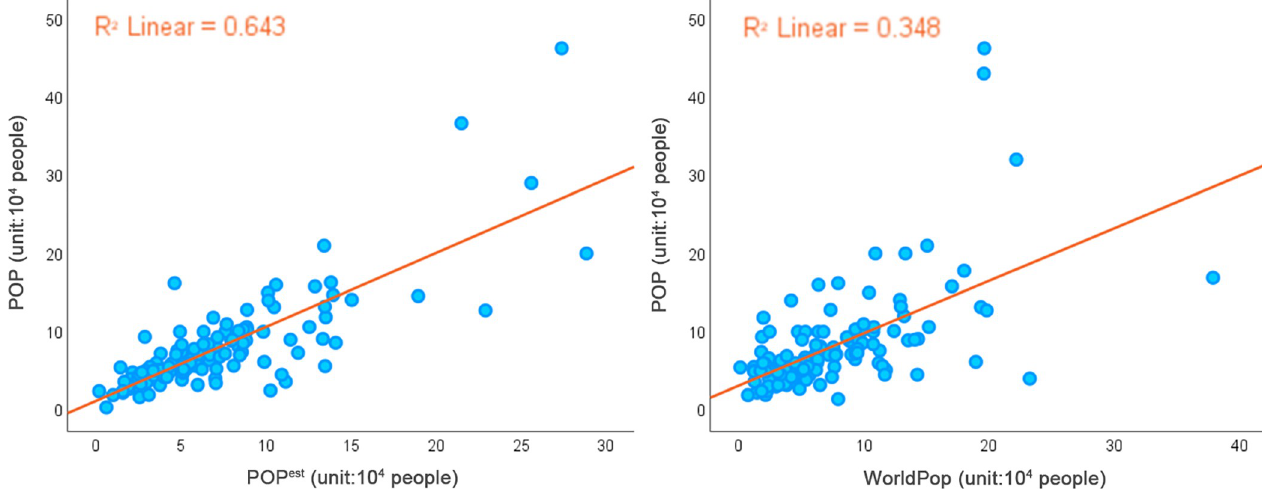
Fig 11. R 2 between (a) POP est and (b) Worldpop datasets and real statistical results.